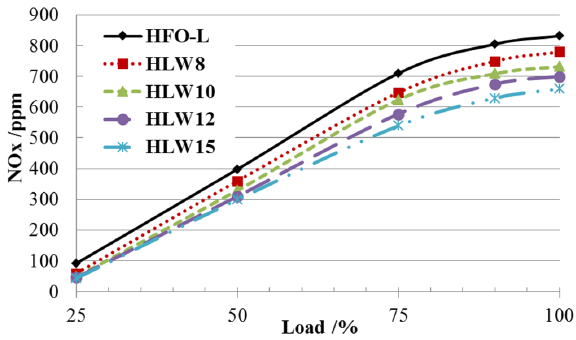
Figure 15. Variation tendency of NO x emissions.